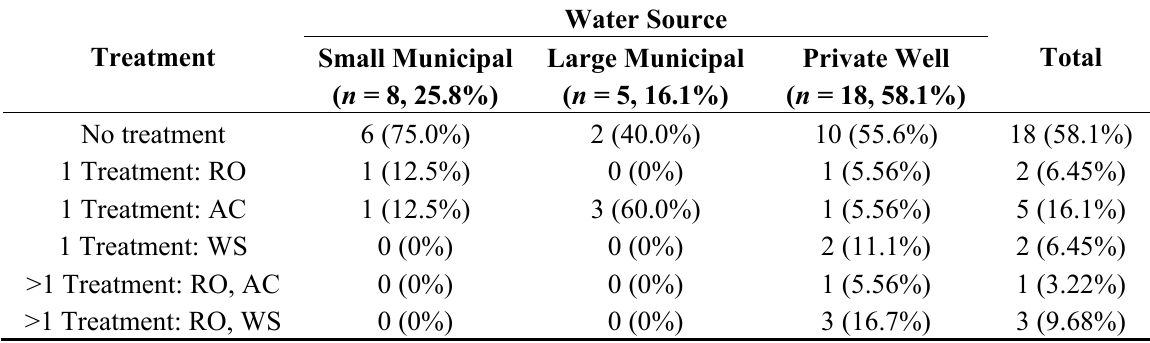
Table 1. Number of homes using various home water treatments ( n = 31). RO: reverse osmosis, AC: activated carbon, and WS: water